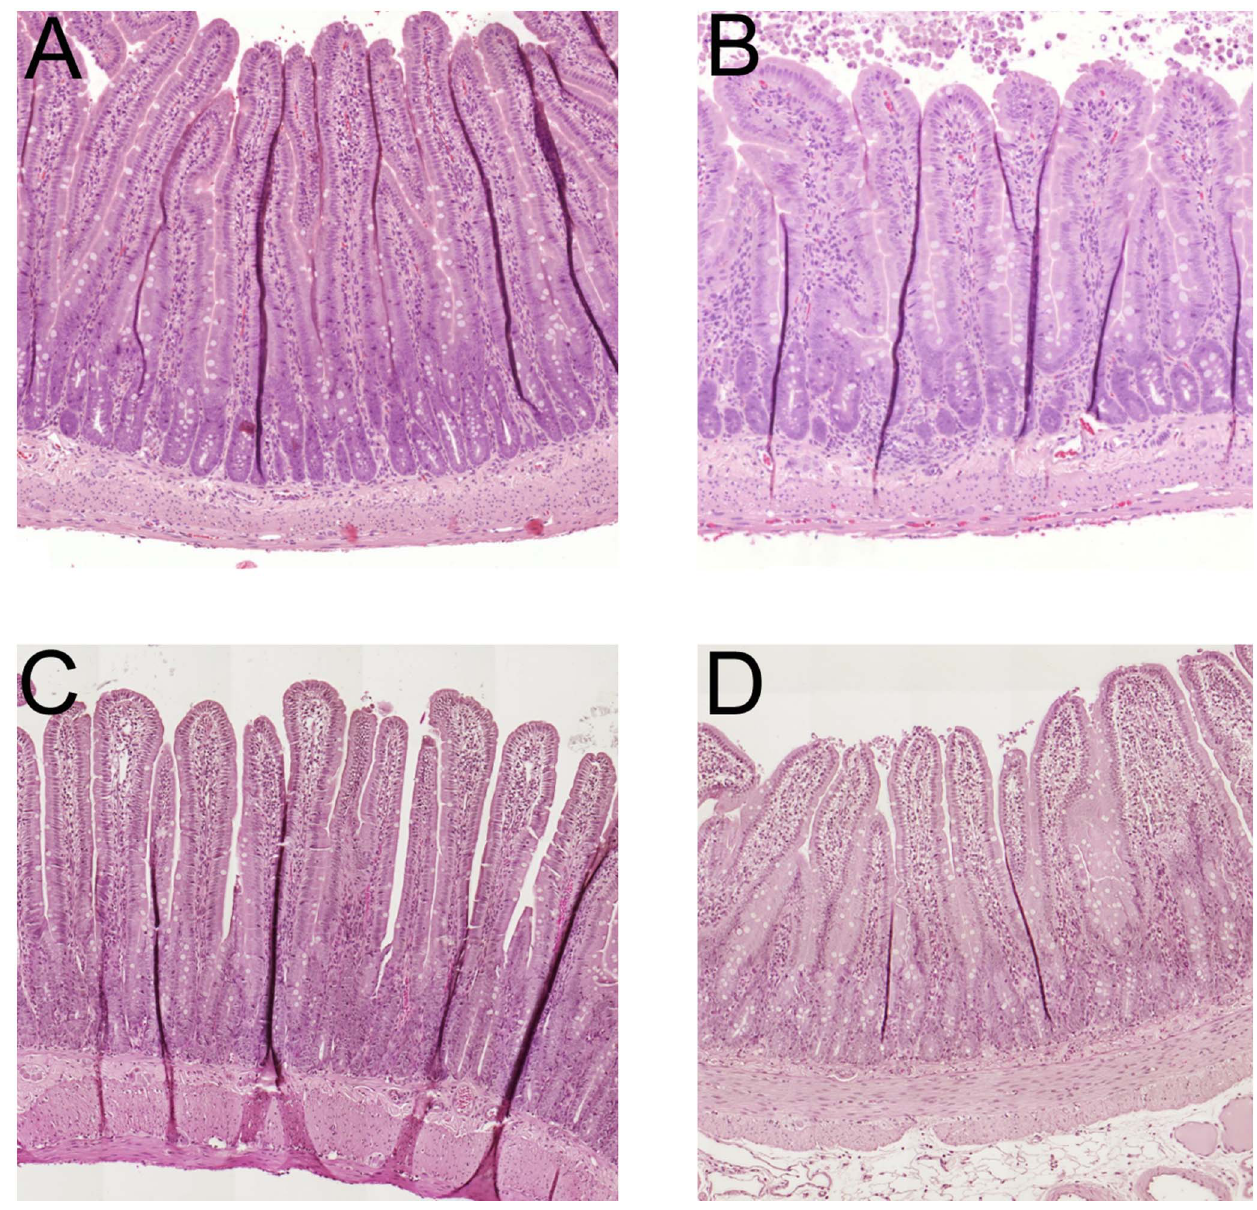
Figure 6. Histology of the duodenal mucosa. The duodenum perfused with isotonic NaCl for 30 min (group I) had a normal morphological appearance (n=4, Fig. 6A). The perfusion of the duodenal segment with 15% ethanol for 30 min (group II) caused mild villous tip damage observed as edema and the beginning of desquamation of the epithelium at the tip of less than 10% of the total villi (n=4, Fig. 6B). The duodenal segment following perfusion of with 1.0 mM hydrochloric acid (pH 3) for 30 min (group III) had a normal morphological appearance (n=4, Fig. 6C). The perfusion of the duodenal segment with 15% ethanol mixed in a hydrochloric acid solution of 1.0 mM for 30 min (group IV) caused mild villous tip damage observed as edema and the beginning of desquamation of the epithelium at the tip of less than 10% of the total villi (n=4, Fig. 6D). The morphological changes in this group were not different from the group perfused with 15% ethanol alone.